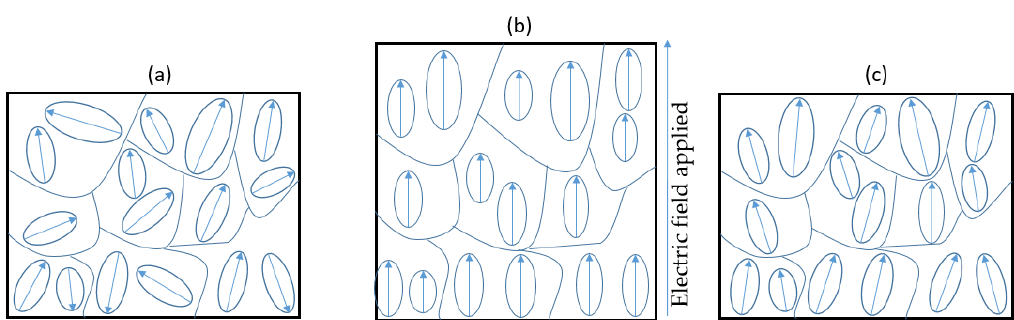
Figure 1. Piezoelectric material polarization with an electric field where: ( a ) is in a neutral state, ( b ) is with an applied field, and ( c ) is after the electric field